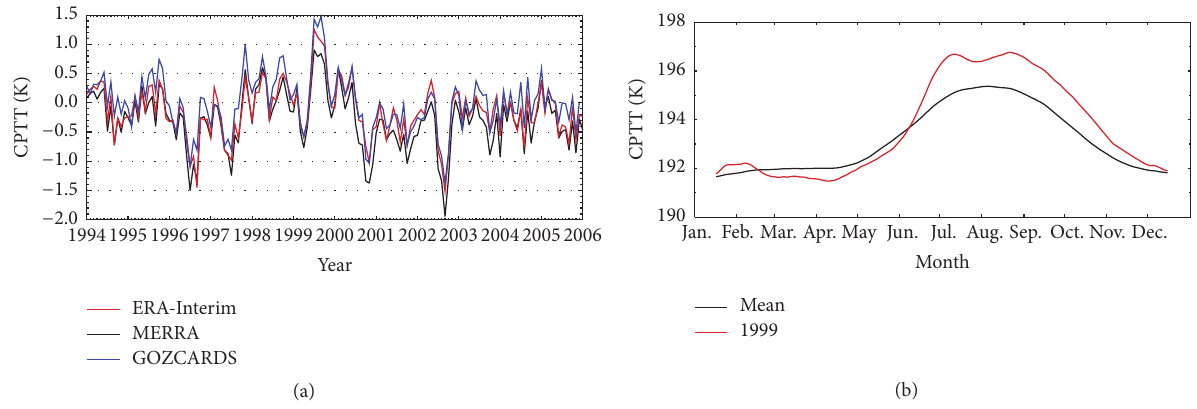
Figure 1: (a) Monthly time series of tropical mean (20 ∘ N–20 ∘ S) CPTT for the period of 1994–2005 derived from ERA-Interim (red line), MERRA (black line), and GOZCARDS (blue line) datasets. (b) Daily tropical CPTT variations in 1999 (red line) and CPTT climatology for the period from 1994 to 2005 (black line).